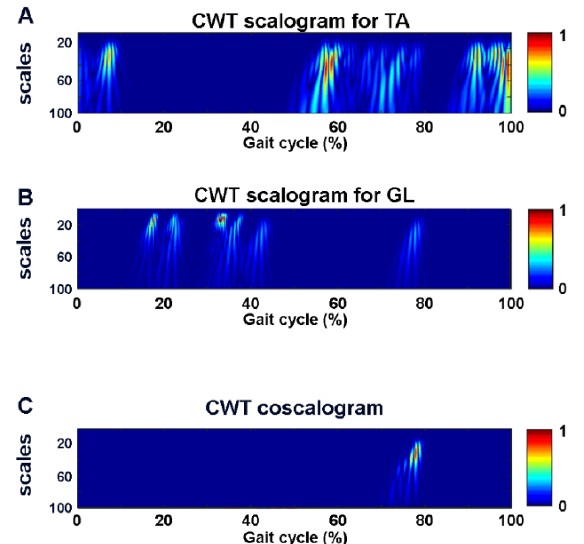
Figure 5. Two-dimensional color representation of CWT scalogram function for TA ( A ) and GL ( B ) denoised sEMG signals and CWT coscalogram between TA and GL ( C ) for a representative stride from subject five.